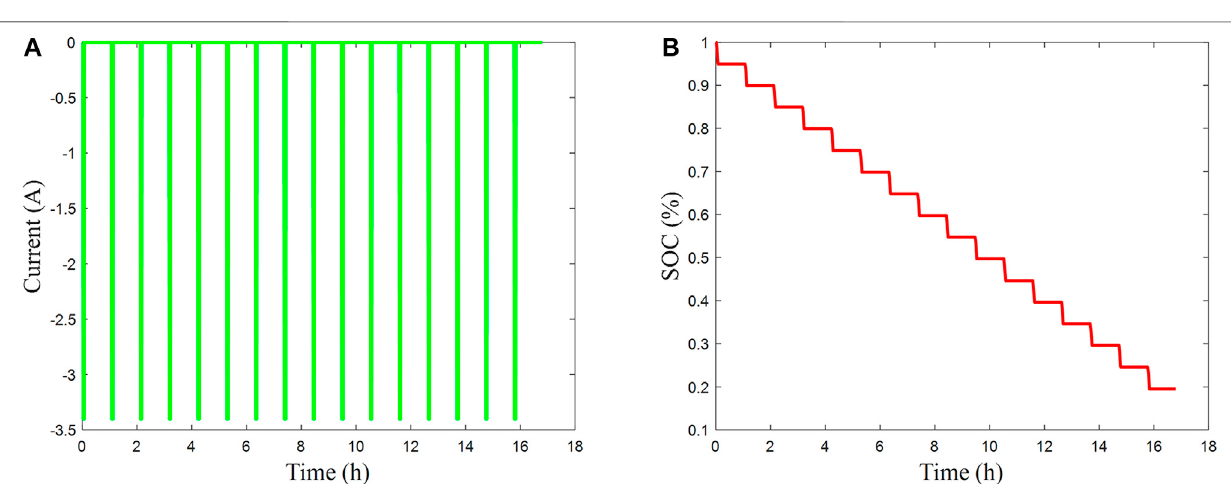
FIGURE 7 | Current and SOC curves of pulse test. (A) Current curve and (B) SOC curve.